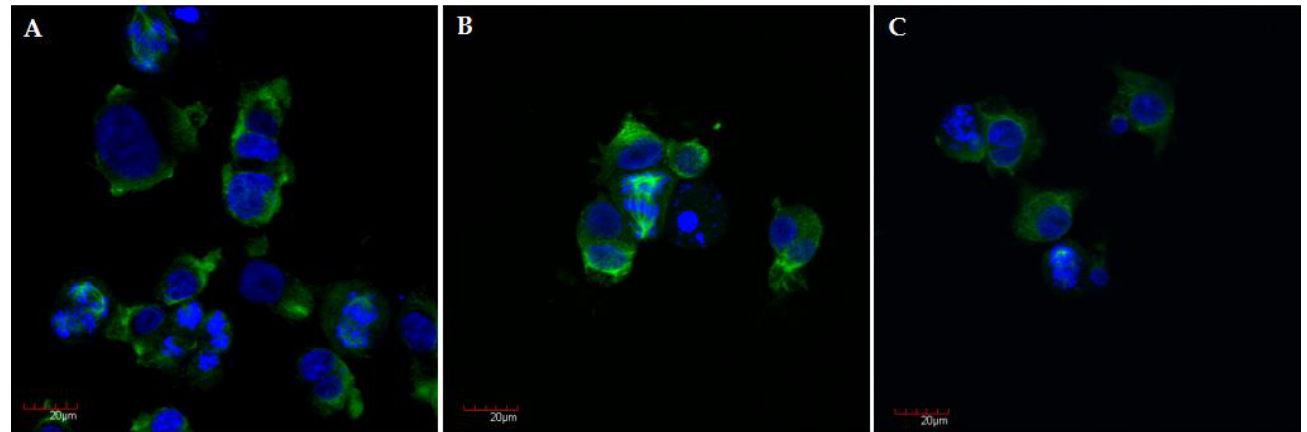
Figure 5. Quantification of mitotic spindle phenotypes of A375 cells after 6 h incubation with indicated compounds at 10 µ M. Data are expressed as the mean and SD from two independent experiments.